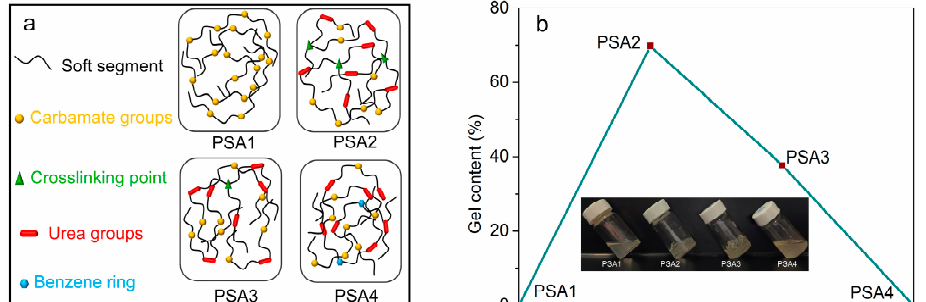
Figure 3. ( a ) Schematic diagram of the structure of the four WPU-PSAs. ( b ) The swelling condition of WPU-PSAs in THF and the corresponded gel contents. PSA1 and PSA4 dissolved completely, and PSA2 and PSA3 swollen with the gel content of 70% and 38%, respectively.